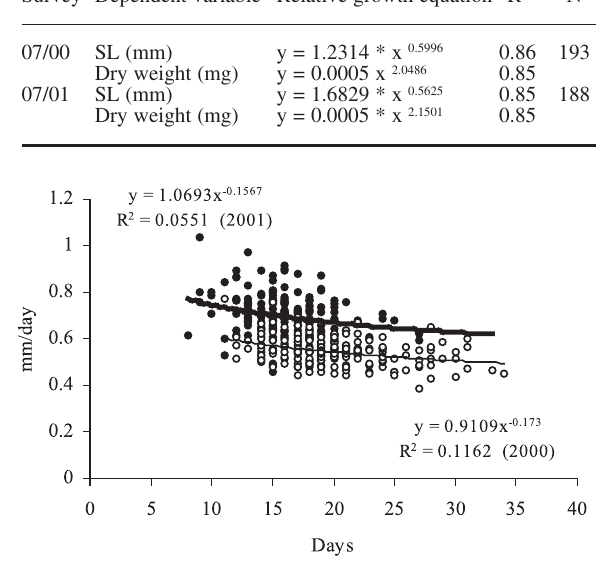
F IG . 8. – Individual growth rates of the E. encrasicolus larval populations spawned during July 2000 and